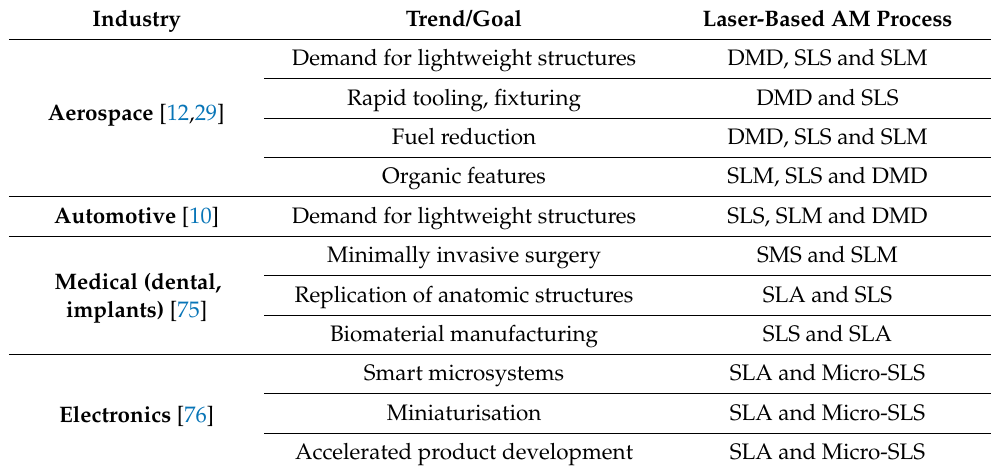
Table 2. Laser-based AM and its applications in various fields